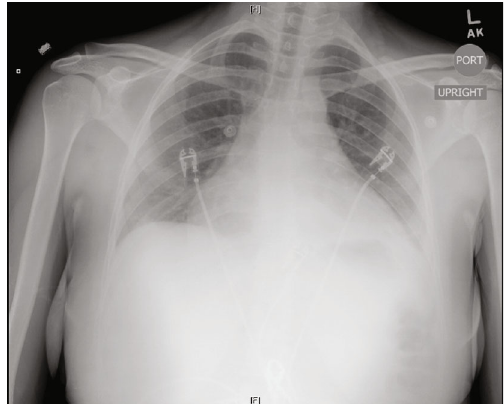
Figure 2: Enlarged cardio-mediastinal